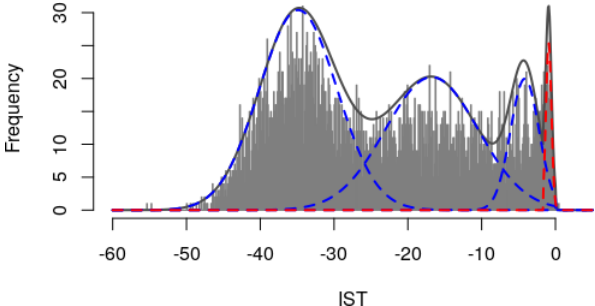
Figure 3. Frequency distribution of daily MODIS IST data from an example cell (82.47, − 37.50) on the Greenland ice sheet between 2001 and 2019. Solid and dashed lines show a mixture model fit to these data where blue indicates the three ice components, red in- dicates the melt component, and black indicates the full model as the sum of the ice and melt components. Each individual compo- nent is a truncated Gaussian distribution, and the lines represent the probability density function of these on a scale matching that of the